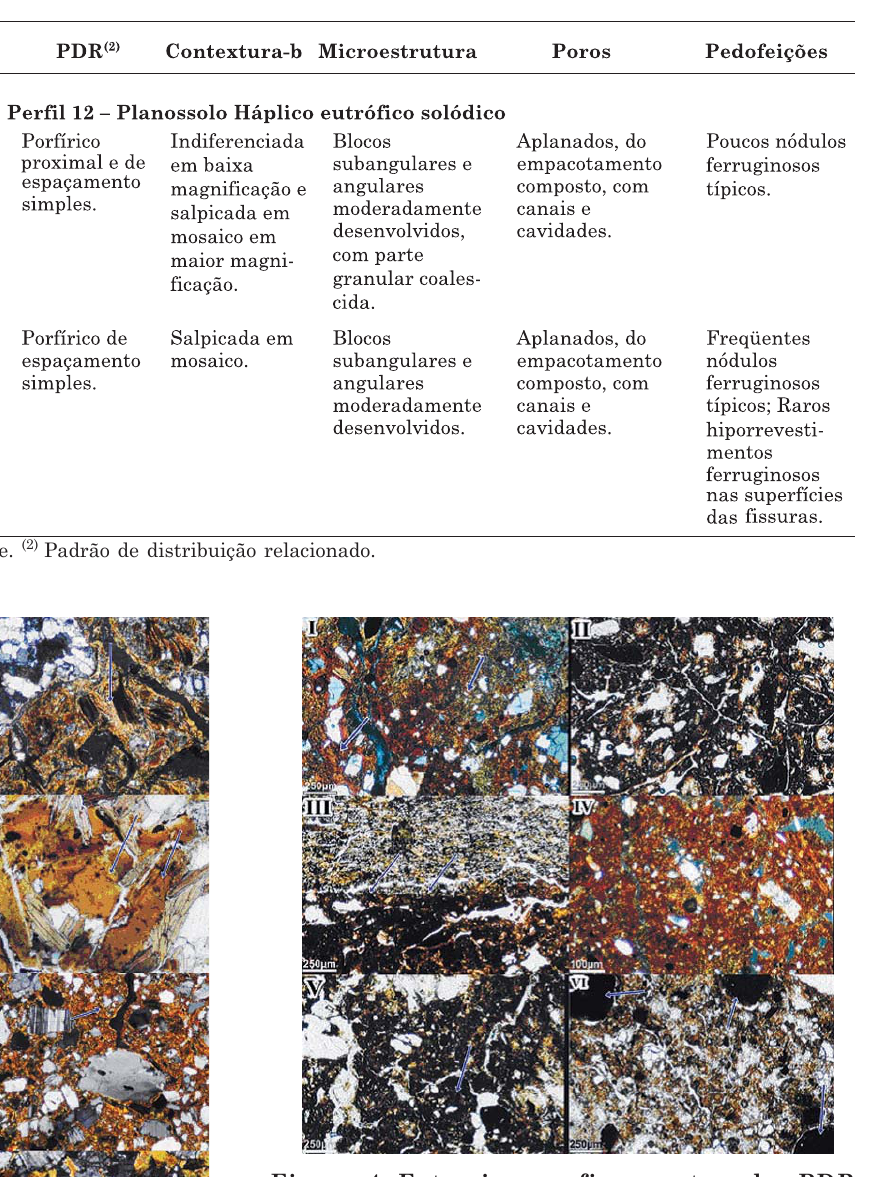
Figura 4. Fotomicrografias mostrando: PDR porfírico do horizonte Bt1 do perfil 10 (I) e do horizonte Bt do perfil 11 (IV); contato entre zonas edafizadas e não-edafizadas no Cr do perfil 10 (III); parte da estrutura em blocos subangulares do horizonte Bt2 do perfil 10 (II) e do Bt do perfil 12 (V); e alguns dos nódulos ferruginosos presentes no horizonte C do perfil 12